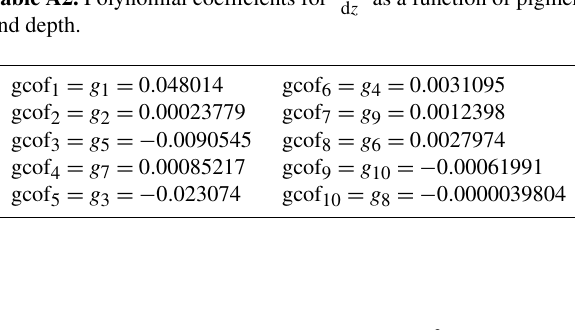
as a function of pigment d z